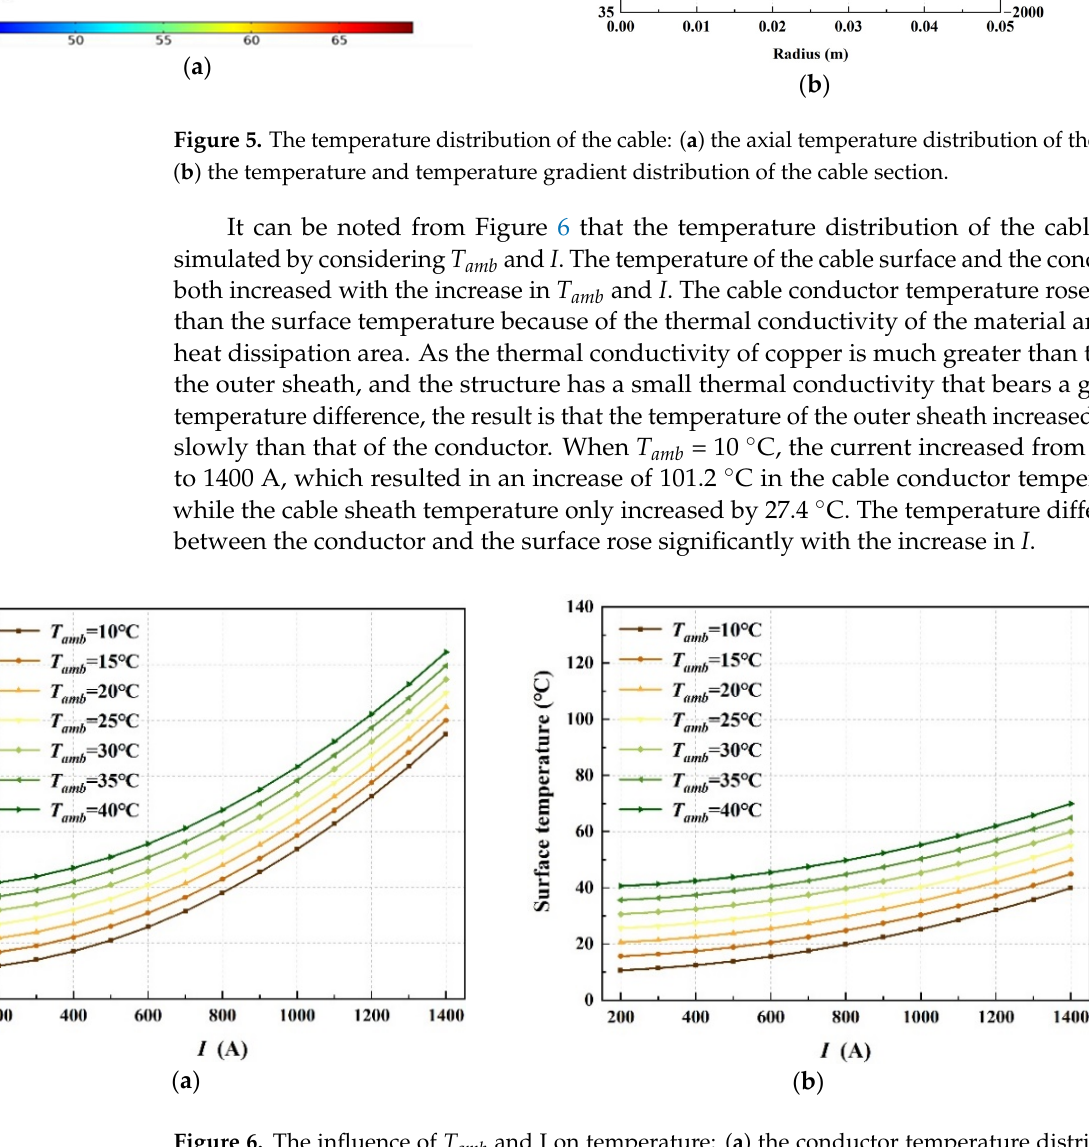
Figure 6. The influence of T amb and I on temperature: ( a ) the conductor temperature distribution curve; ( b ) the surface temperature distribution